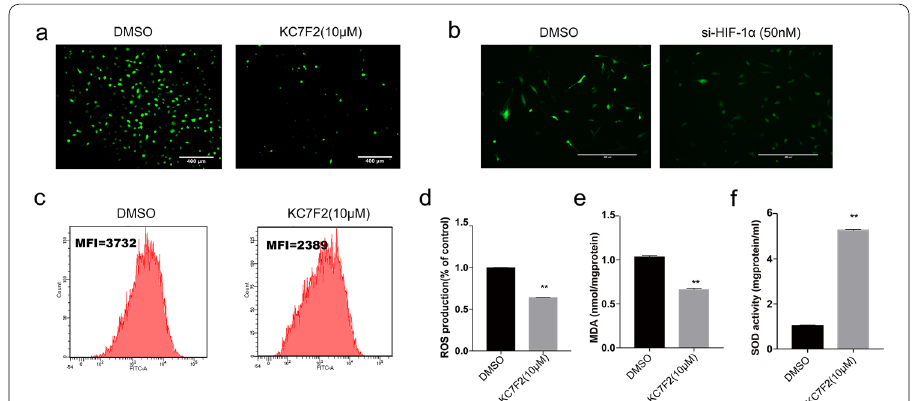
Fig. 4 Effects of inhibition of HIF-1α expression on oxidative stress under hyperglycemia and hypoxia. Assays showing ROS ( a–d ), MDA ( e ) and SOD activity ( f ) compared with control. Downregulation of HIF-1α decreased expression of ROS and MDA, and increased SOD activity significantly compared with the control group following combined stimulation. n 3; * p < 0.05 and ** p < 0.01 vs. DMSO. DMSO-treated cells, DMSO; = HIF-1α inhibitors KC7F2 (10 µM)-treated cells, KC7F2 (10 µM); si-HIF-1α, small interfering RNA HIF-1α; HG, high glucose; HG Hypoxia, combined stimulus with high glucose and hypoxia; NG, +